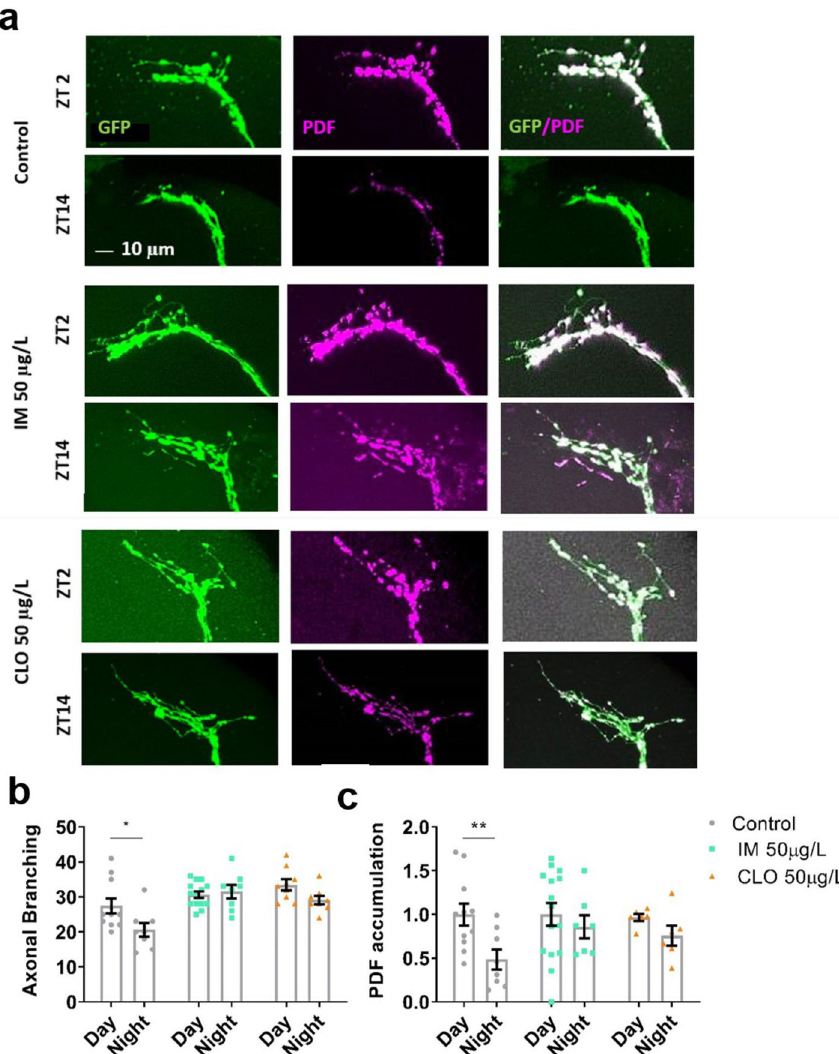
Figure 5. Field relevant concentrations of neonicotinoids disrupt the day/night remodelling and PDF cycling in the s-LNv clock neuron dorsal terminals. (a ) Representative confocal images of the s-LNv dorsal terminals for control and treated (50 µg/L IM or CLO) flies in the day (ZT2 i.e. 11am) and night (ZT14 i.e. 11 pm). ( b ) s-LNv dorsal terminal branching complexity is greater in the day than at night for control flies ( t 17 = 2.3, p = 0.036). The day/night differences in complexity is removed in flies exposed to 50 µg/L of IM ( t 14 = 2.1, p = 0.055) or CLO ( t 15 = 2.1, p = 0.052). ( c ) Accumulation of PDF in dorsal terminals is greater in the day than at night in control flies ( t 17 = 2.9, p = 0.010), treatment with 50 µg/L IM ( t 13 = 1.0, p = 0.332) or CLO ( t 14 = 2.1, p = 0.054) removed this day/night difference in PDF levels. Each data point represents a single brain, n = 6–15